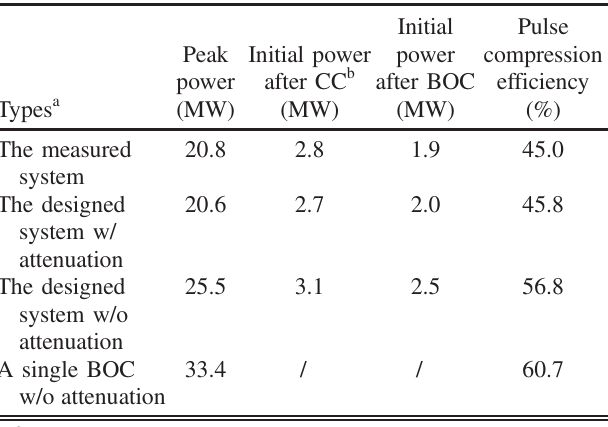
TABLE I. The calculated results according to